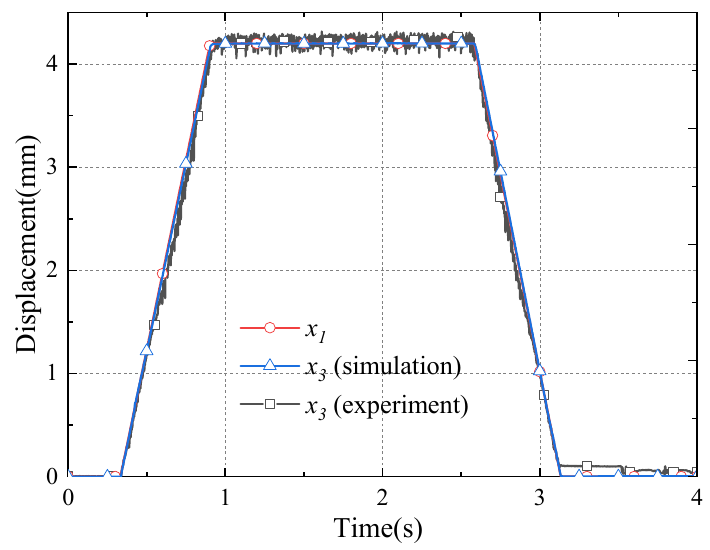
Figure 11. Response of test result under ramp signal.